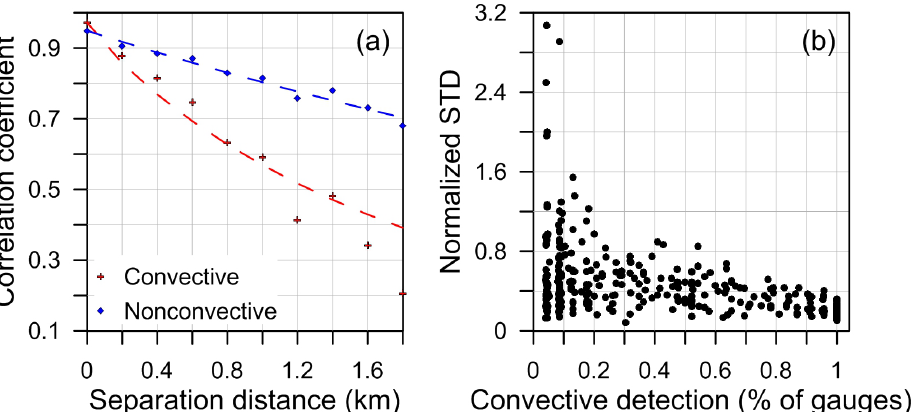
Fig. 6. (a) Correlogram presenting the convective (red plus symbol) and nonconvective (blue dots) spatial rainfall coefficient and its fit (dashed lines) using the three-parameter exponential functions. (b) Convective rain intensity normalized standard deviation. The analysis was performed for the 5min rain intensity data.